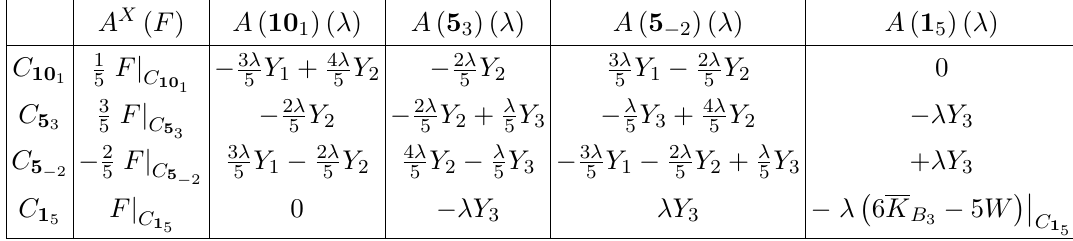
Table 3. Line bundles (viewed as divisors on the matter curves) induced by the (cid:13)uxes A X ( F ), A ( 10 1 ) ( (cid:21) ), A ( 5 3 ) ( (cid:21) ), A ( 5 (cid:0) 2 ) ( (cid:21) ) and A ( 1 5 ) ( (cid:21) ). Tensoring with the respective spin bundles gives the line bundles whose cohomologies count the massless matter. A X ( F )